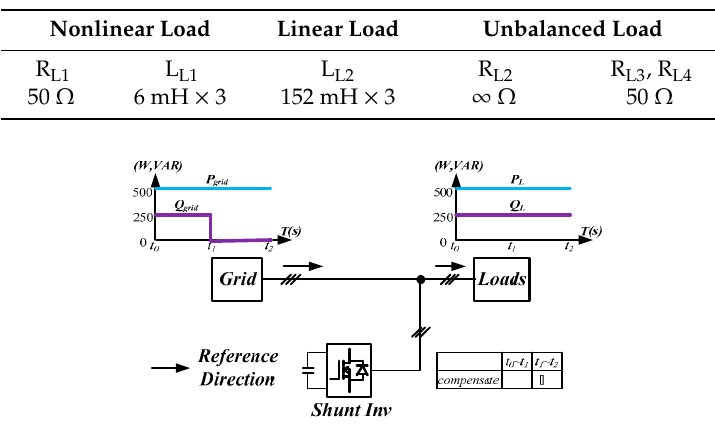
Figure 12. Schematic diagram of simulated scenario.